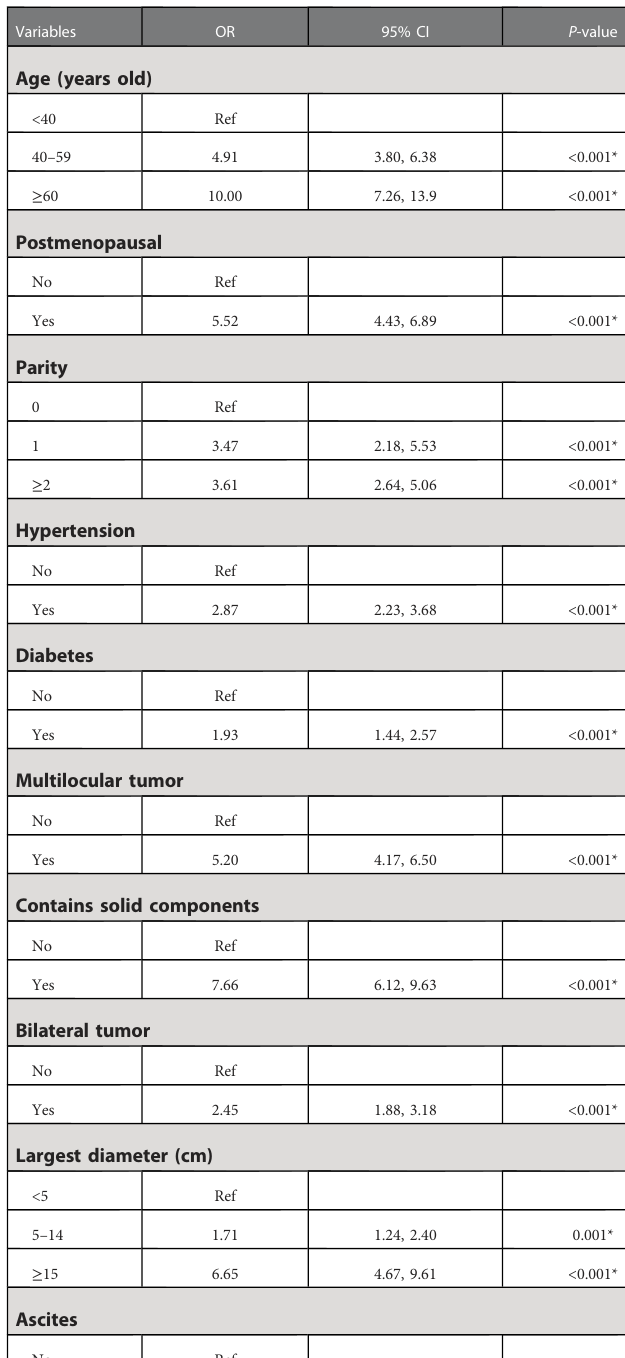
TABLE 2 The univariable logistic regression analysis of epithelial ovarian